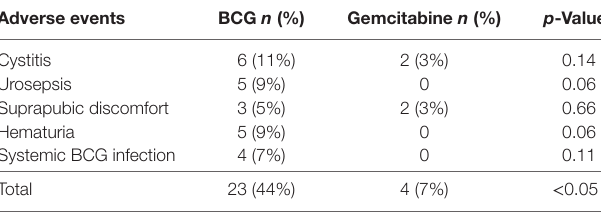
TaBle 3 | Adverse events.